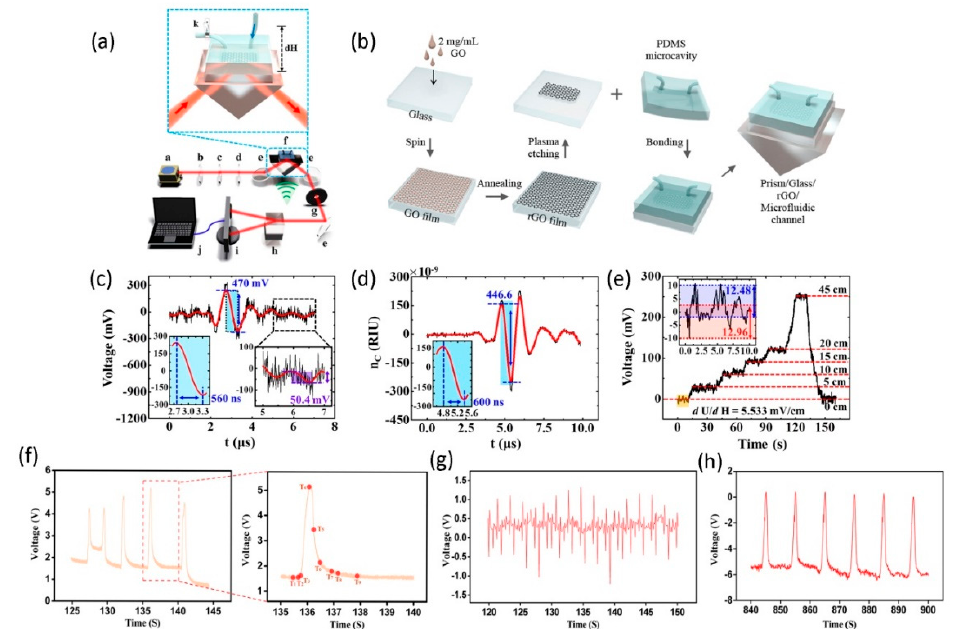
Figure 7. ( a ) Diagram of the experimental setup for the rGO-based microfluidic optical sensor. ( b ) The flow chart of the preparation for microfluidic optical sensing chips. ( c ) The weak RI variation of the solution corresponds to the pressure provided by ultrasound. ( d ) The optimized RI changes the detection of water. ( e ) The relationship between the liquid level in the catheter and the voltage signal response. Reproduced from [98] with the permission from Frontiers Media S.A. ( f ) The voltage-time signal collected from the video, the illustration shows the voltage-time signal between 135 and 140 s. The voltage and time signals corresponding to the liquid being pumped at higher ( g ) and lower ( h ) speeds, respectively. Reproduced from [99] with the permission from The Optical Society.